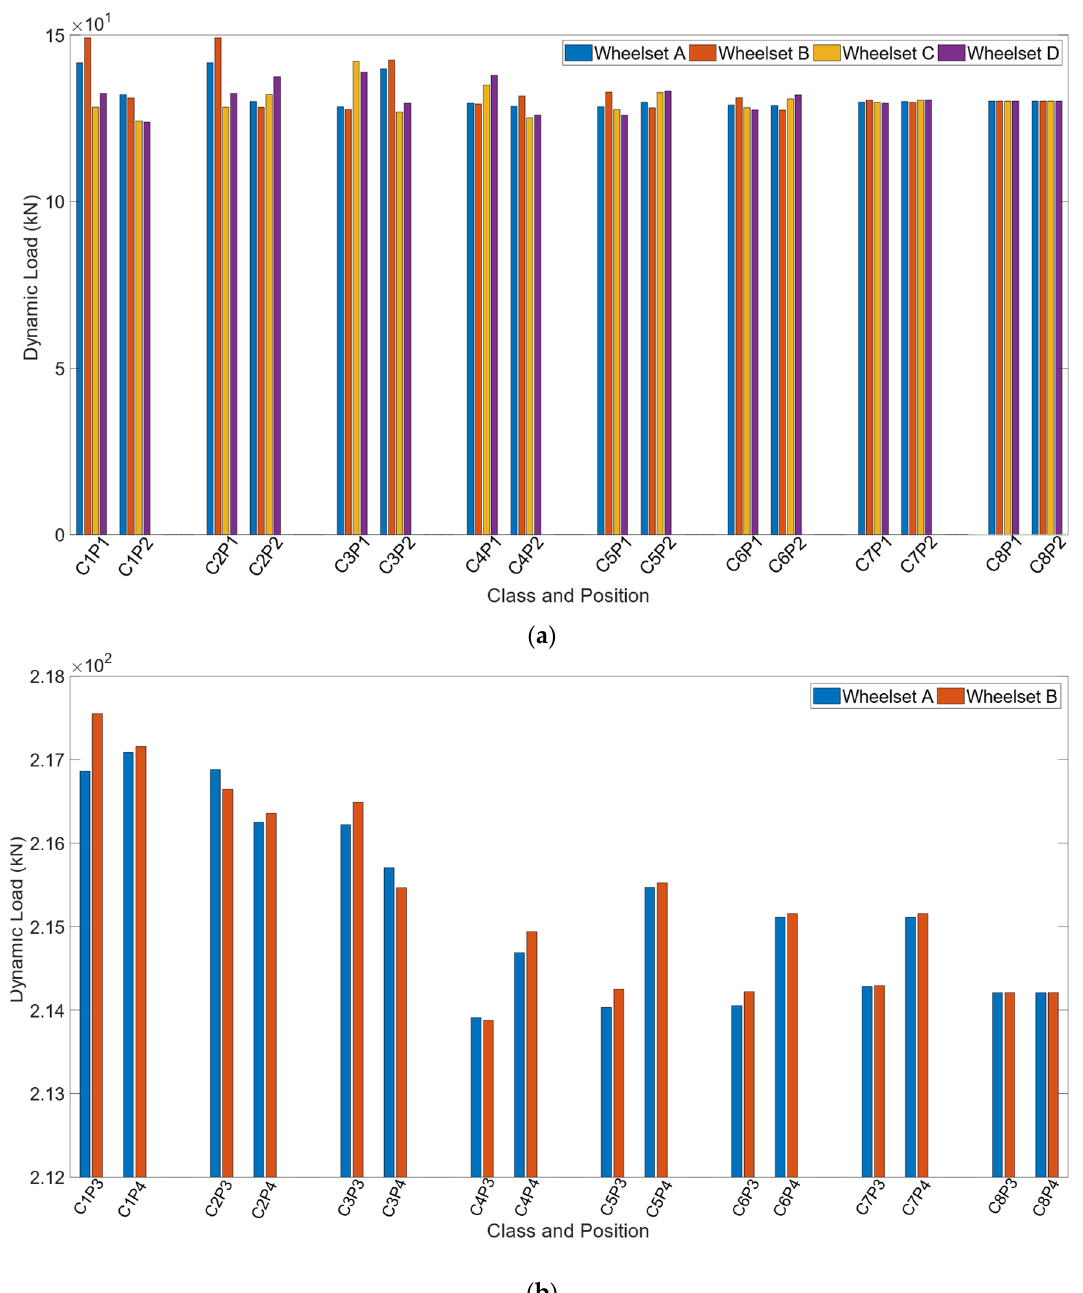
Figure 8. Influence of the position of the system installation in the assessment of the dynamic load for ( a ) Alfa Pendular; ( b ) freight wagon. for ( a ) Alfa Pendular; ( b ) freight